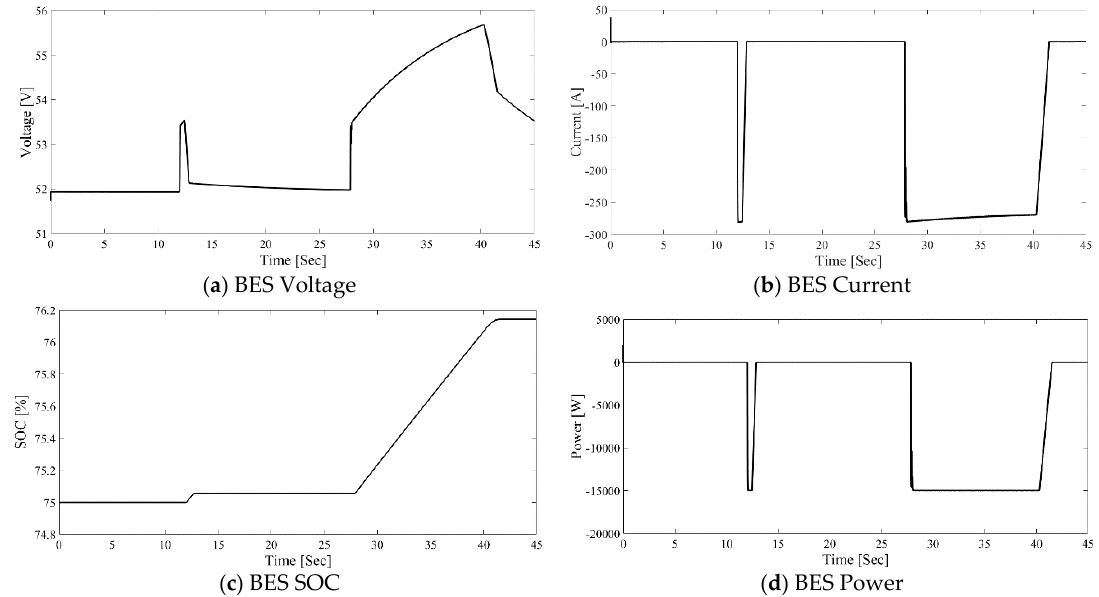
Figure 13. UCES parameters in complete 45-s elevator working cycle.